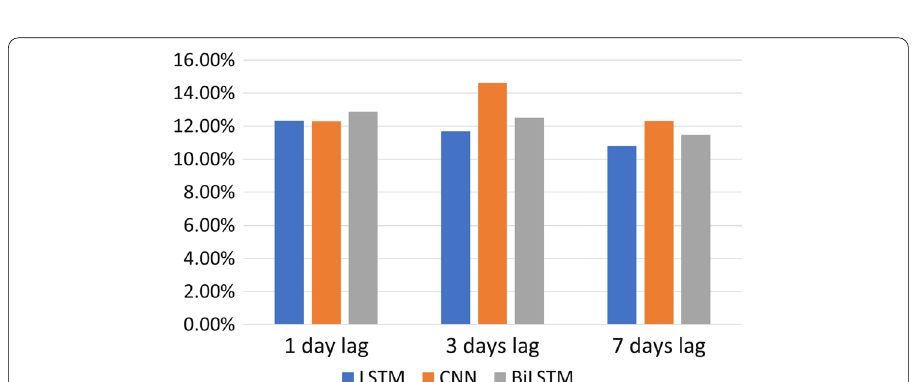
Fig. 13 F1 scores of different models on price change magnitude prediction across time lags